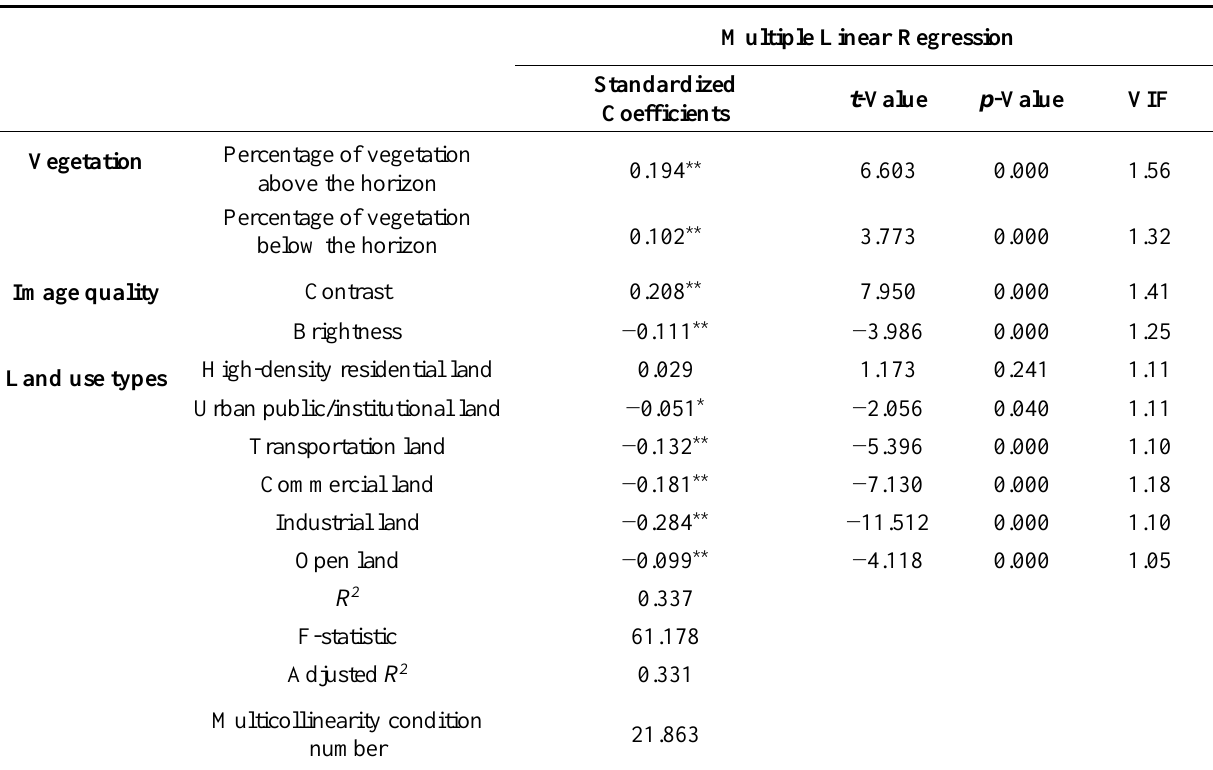
Table 3. Summary of the multiple linear regression analysis between perceived safety and explanatory variables for all Place Pulse sites. VIF, variance inflation